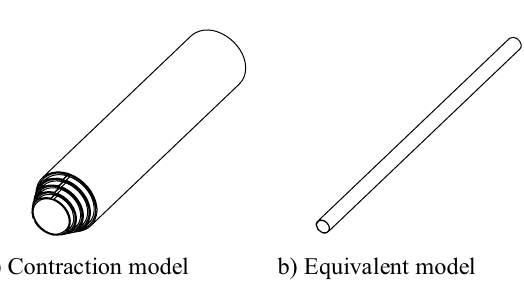
Figure 7 Model of TTM contraction and extension state: a